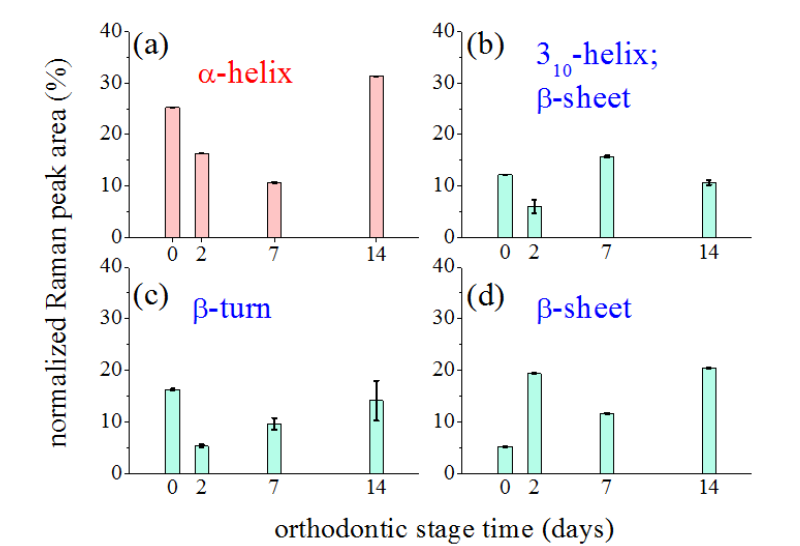
Figure 6. Changes induced by orthodontic force application on the Raman signal intensity of the main components of the Amide I band. Reported data refers to percentage of normalized areas of considered components in whole Amide I band area, assumed equal to 1. Black bars indicated error of area value determination.